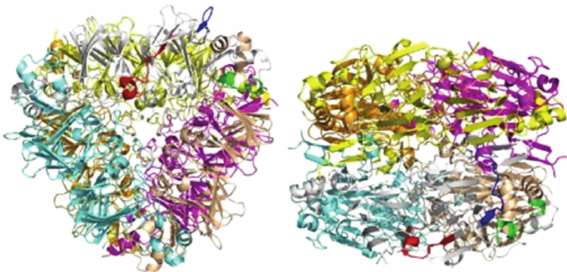
Figure 3: Ara h 3 is represented with each of the monomers shown in a different color. In the gray monomer, linear epitope 1, 2, and 3 are shown in red, green, and blue, respectively [30].